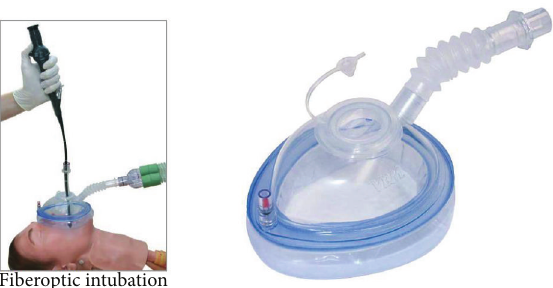
Figure 1: Left frontal view of oral aperture with tracheostomy in place.